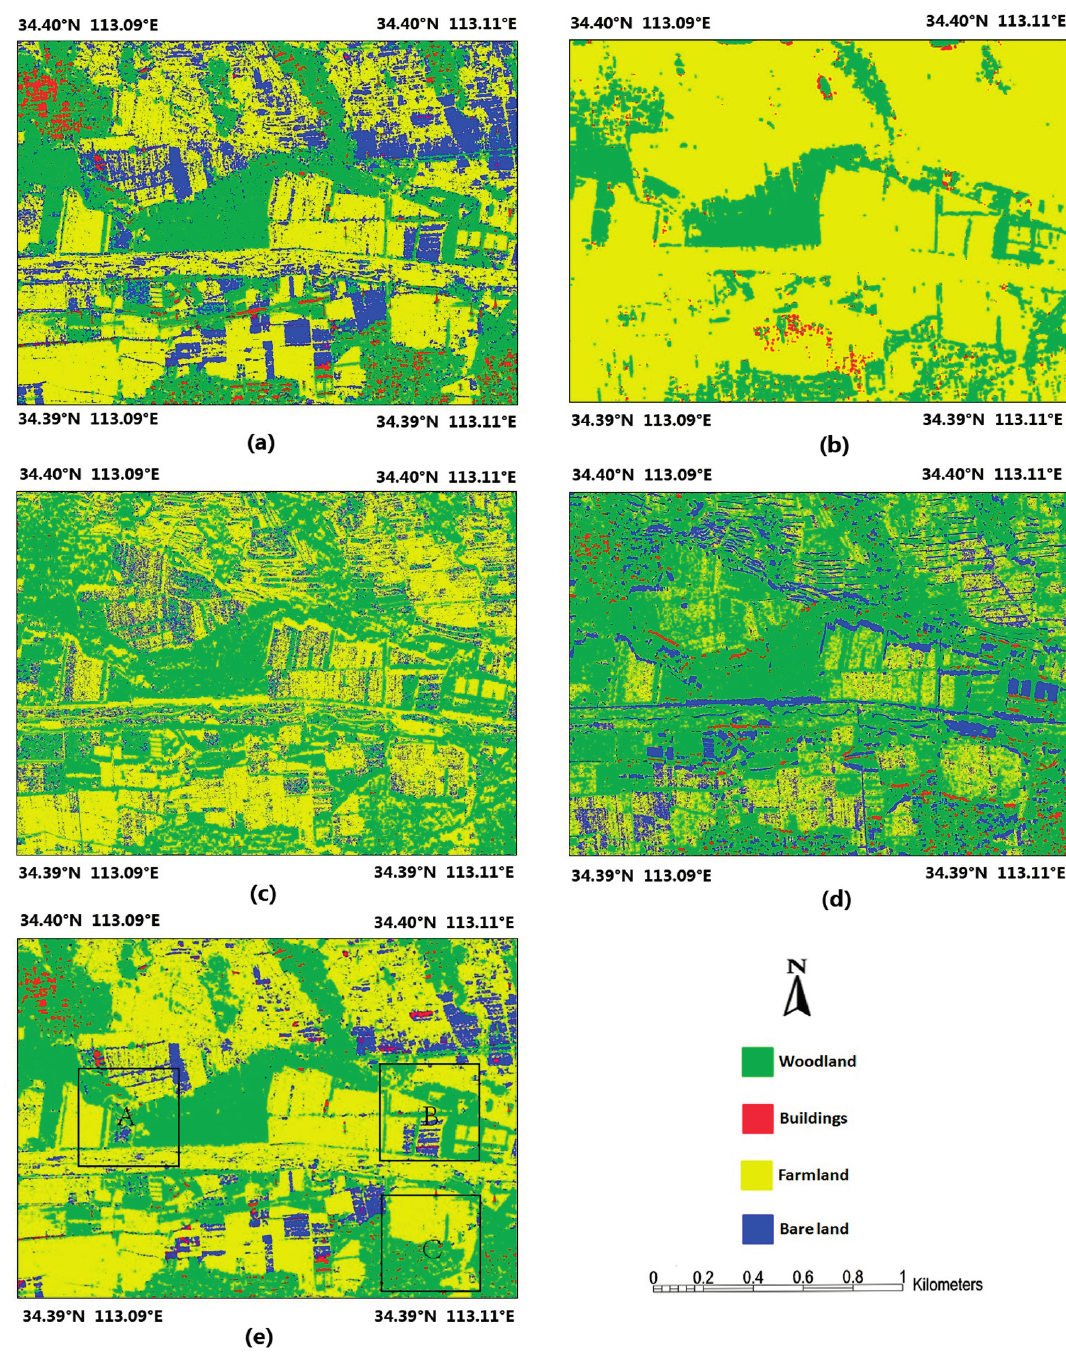
Figure 9. The classification results of the CASMSAR data. ( a ) The supervised classification result of the P-band PolSAR image. ( b ) The unsupervised classification result of the X-band InSAR elevation map. ( c ) The supervised classification result of the P-HH polarized image. ( d ) The K-means fusion classification result. ( e ) The D-S fusion classification